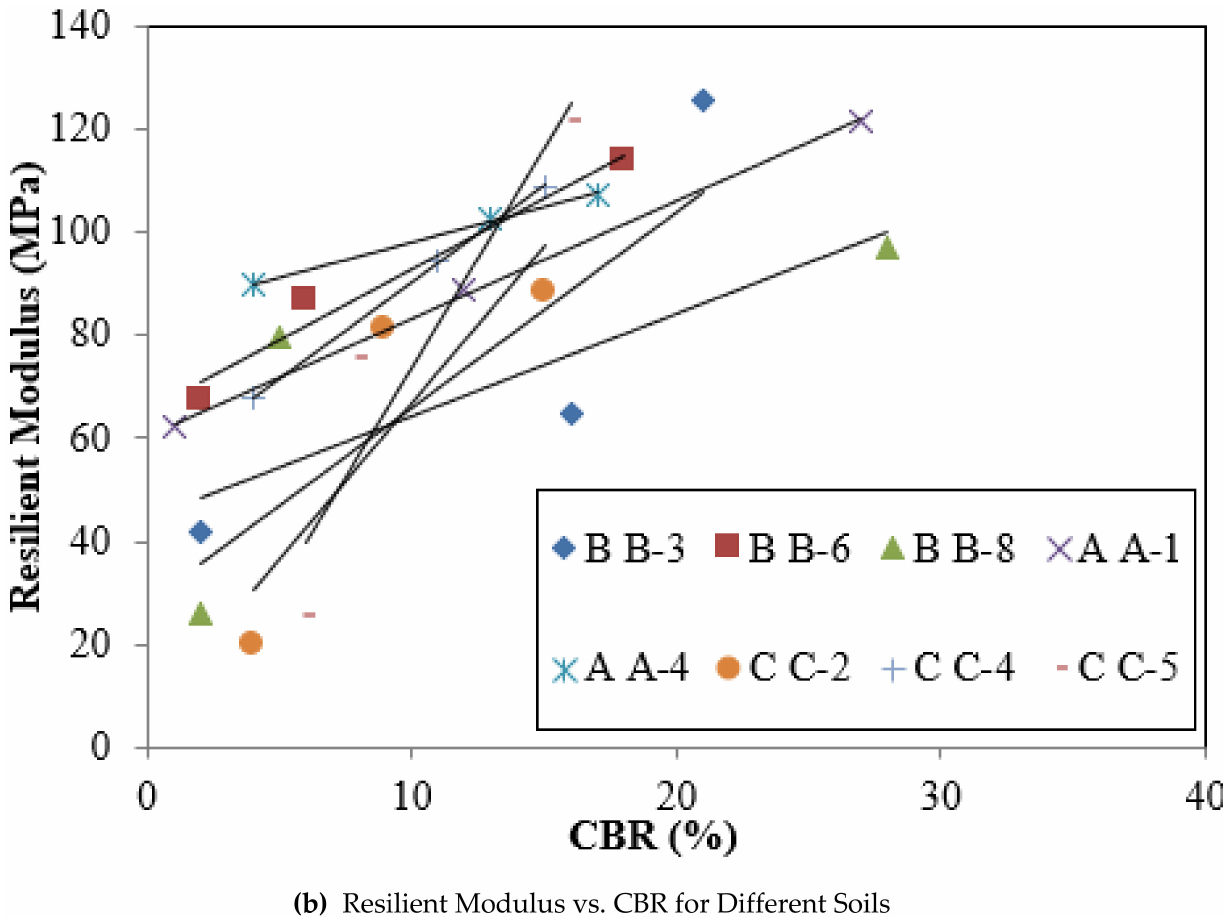
Figure 5. Resilient Modulus with